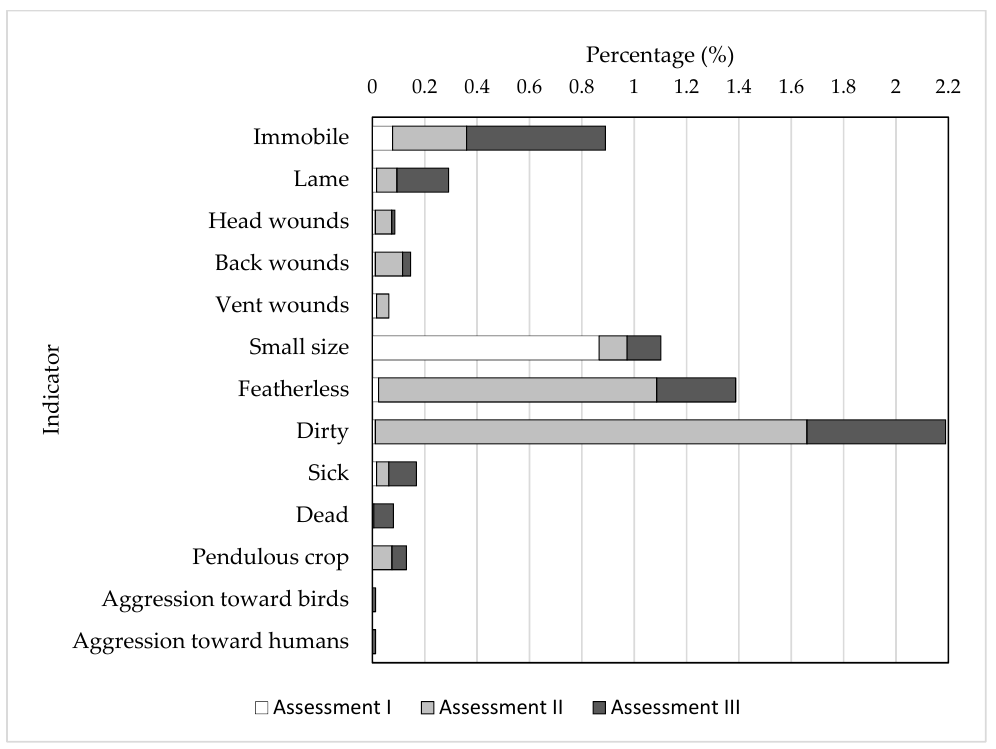
Figure 1. Mean values of welfare indicators recorded in meat-type turkeys at 3 to 4 (Assessment I), 13 to 14 (Assessment II), and 17 to 19 weeks of age (Assessment III). Table 5. Mean temperature and CO 2 and NH 3 values in turkey facilities at each assessment.